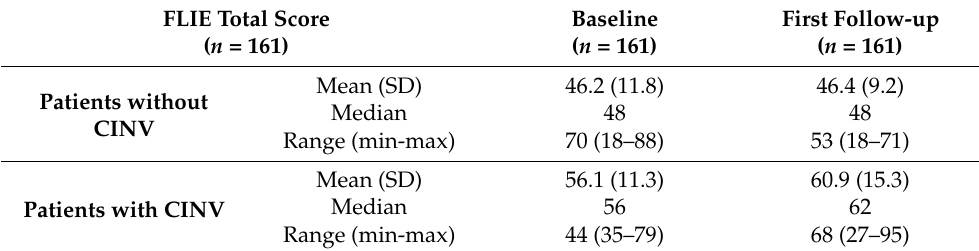
Table 5. Quality of Life assessment based on FLIE questionnaire score. FLIE Total